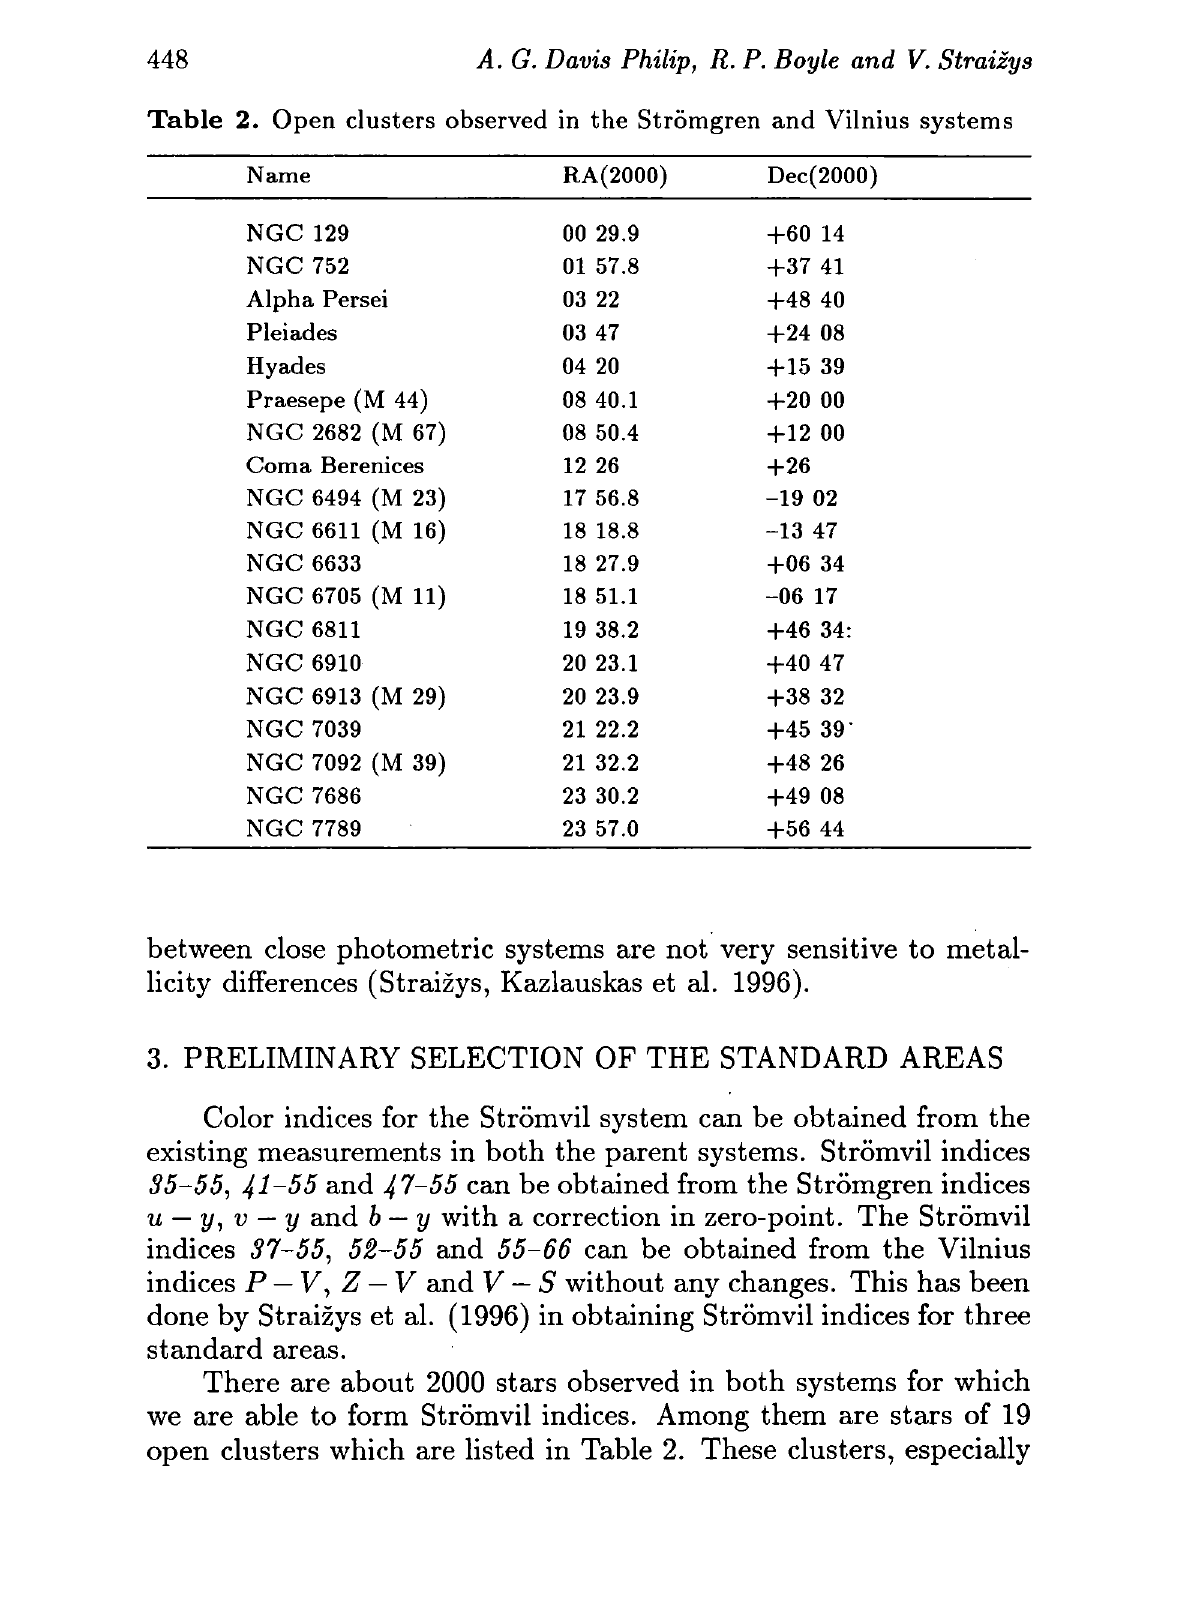
Table 2. Open clusters observed in the Strömgren and Vilnius